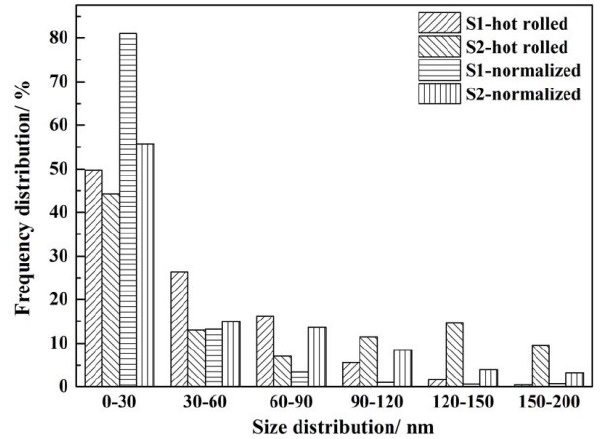
Figure 10: Size distribution of precipitates